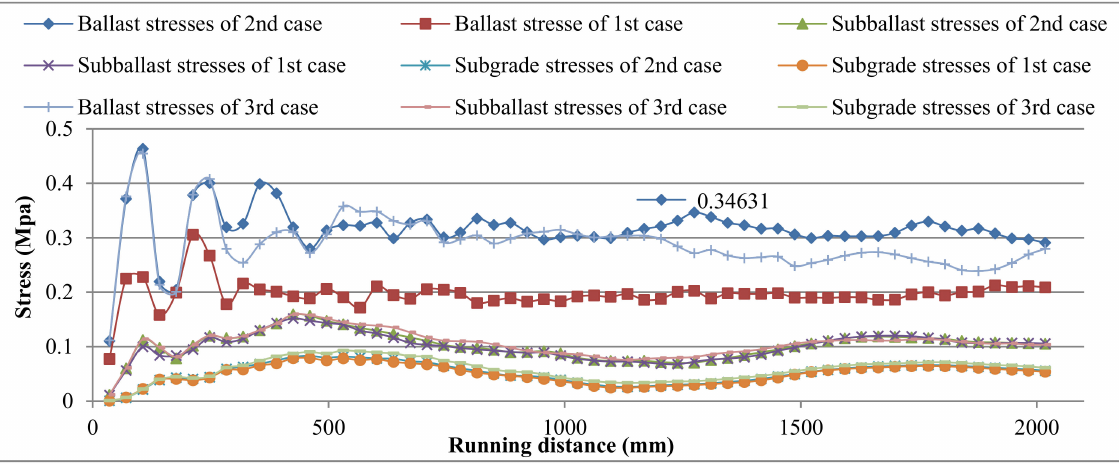
Figure 15. Substructure stresses.